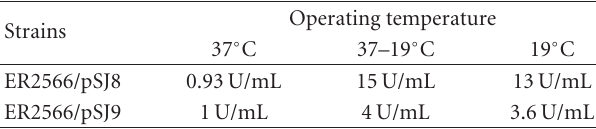
Table 2: E ff ect of the operating temperature on the production of the active US132 CGTase by E. coli ER2566/pSJ8 and ER2566/pSJ9. Operating Strains